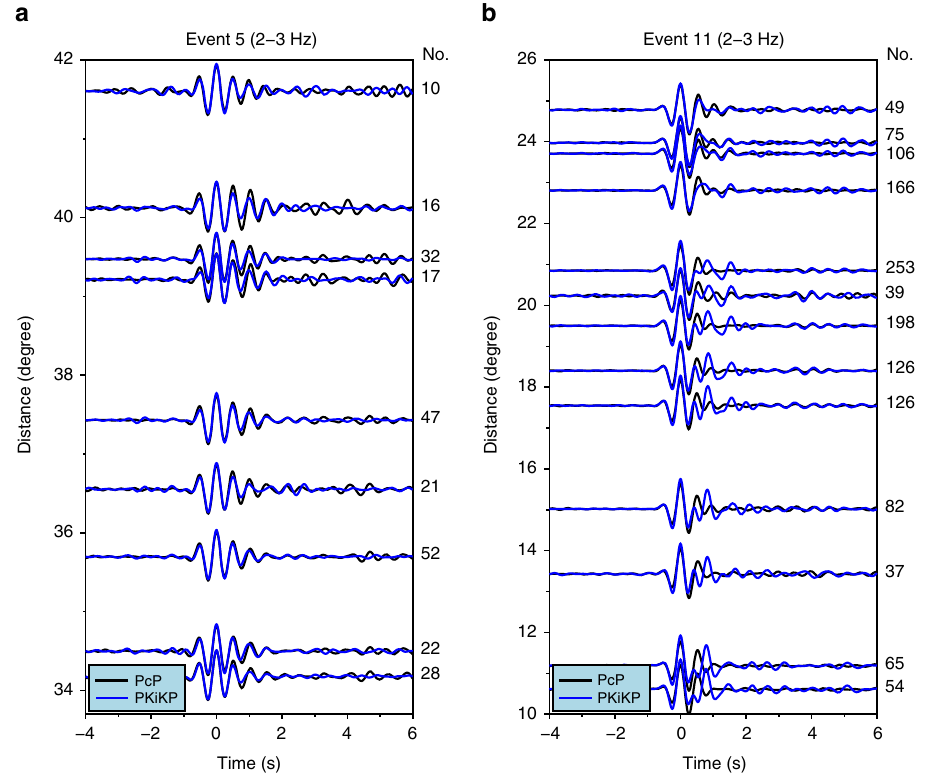
Fig. 3 Comparisons of stacked PKiKP and PcP waveforms of two example events sampling two regions of ICB with different seismic characteristics. a Comparisons for event 5 which samples a sharp ICB beneath central China ( black box labeled as A1 in Fig. 2b). b Comparisons for event 11 which samples a double-layered mushy ICB beneath southwest Okhotsk Sea ( black box A4 and blue box B in Fig. 2b). Stacked PcP ( black traces ) and PKiKP ( blue traces ) waveforms are bandpass fi ltered in a frequency range of 2 – 3 Hz. The number of waveforms used in each stacking is indicated at the right of each